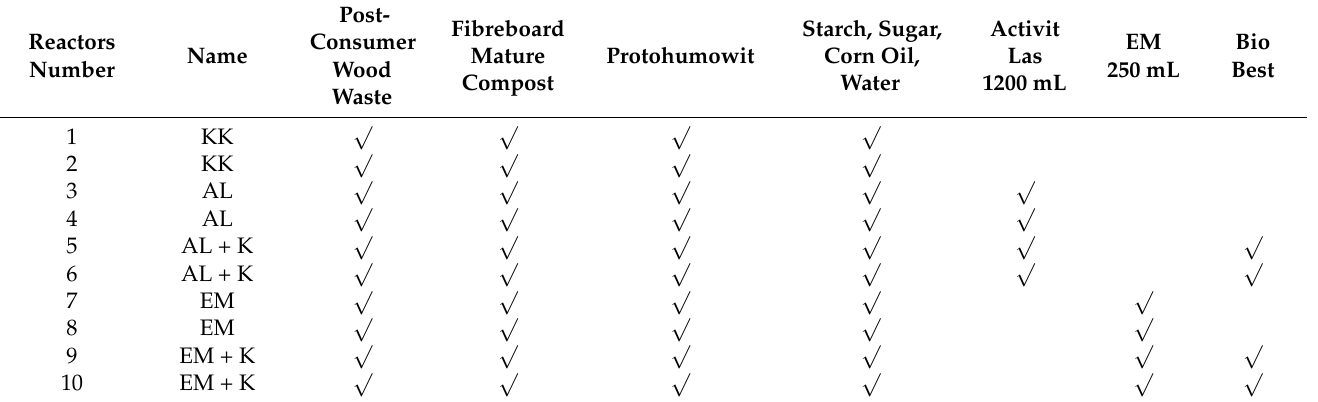
Table 1. The combinations of compost mass in reactors.